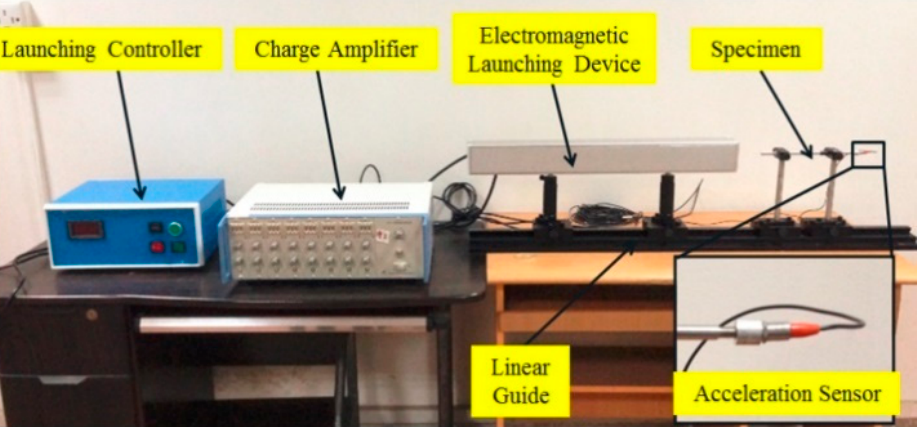
Figure 13. Impact test platform.